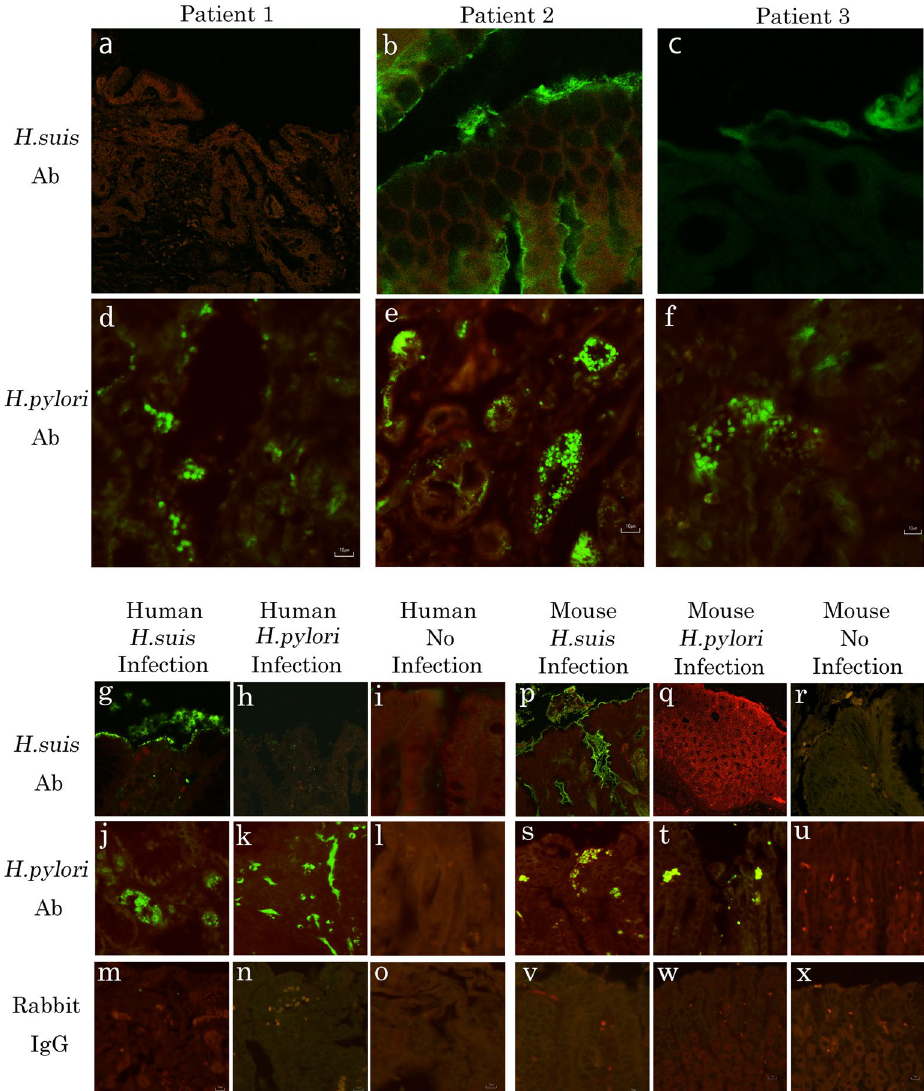
Figure 2. Immunofluorescent staining for Helicobacter suis ( H. suis ) HsvA and H. pylori . ( a – c ) Immunofluorescence staining of H. suis for the three NHPH positive patients’ gastric mucosa is shown. ( a ) Gastric mucosa of Patient 1 was negative for H. suis staining. (× 476). ( b ) Gastric mucosa of Patient 2 was strongly positive for H. suis . H. suis was located not only to surface mucosa, but also to deep in the glands. (× 476). ( c ) Surface mucous cells in glands of Patient 3 was also positive for H. suis . (× 1890). ( d – f ) Immunofluorescence staining with H. pylori antibody which reacts also with NHPH. ( g – o ) Positive control and negative control of each antibody for human gastric mucosa. ( p – x ) Positive control and negative control of each antibody for mouse gastric